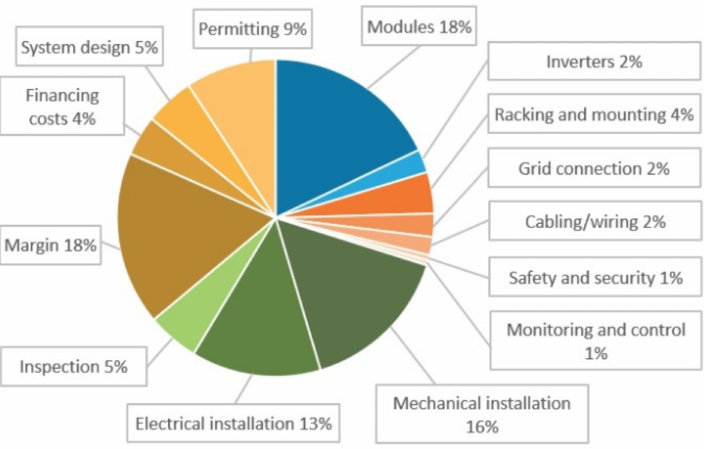
Figure 4. Cost structure of solar power plants in Russia in 2020. Data from